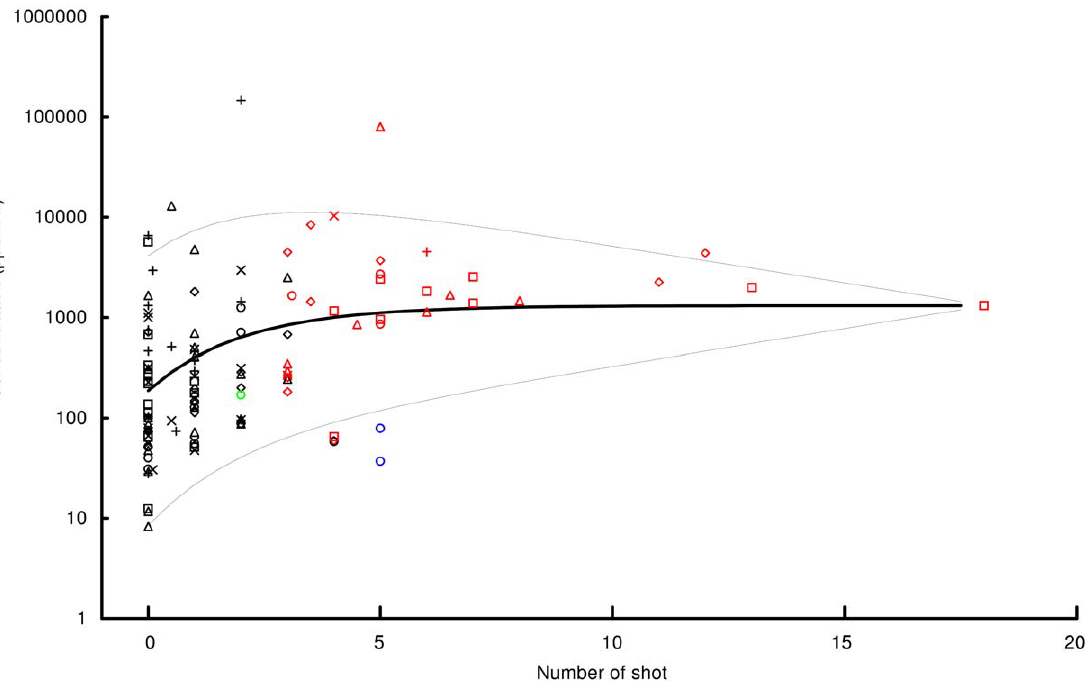
Figure 10. Lead concentration in gamebirds in relation to the number of gunshot pellets in the carcass. Concentration of lead (ppb) per unit mass of cooked meat (wet weight) of gamebirds in relation to the number of gunshot pellets detected on X-rays of the carcass. Each symbol represents results for one bird with species denoted as follows: diamond=red grouse, circle=mallard, triangle=partridge, square=pheasant, x=woodpigeon, + =woodcock. Black symbols denote samples for which the composition of the shot was not assayed or for which colorimetric analysis was inconclusive (1 bird). Red symbols denote samples in which the colorimetric analysis detected lead. Blue symbols denote samples in which lead was not detected and in which the shot were considered to be composed primarily of bismuth alloy and the green symbol a bird from which only steel shot were recovered. The thick curve shows the fitted relationship between concentration and pellet number and the thin curves show the 5 th (lower) and 95 th percentiles (upper) of the distribution, estimated from the model fitted to the data, excluding the three birds considered to have been shot only with bismuth alloy or steel. doi:10.1371/journal.pone.0010315.g010 PLoS ONE |